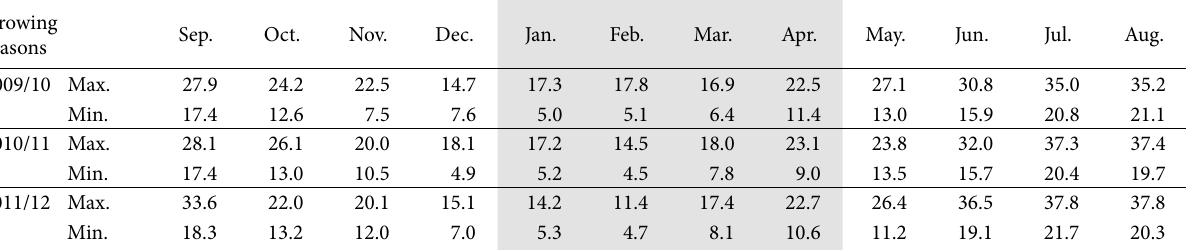
Table 2. Minimum and maximum temperatures recorded during the experimental period. The critical period for pathogen infection and disease development is highlighted in gray. Growing seasons